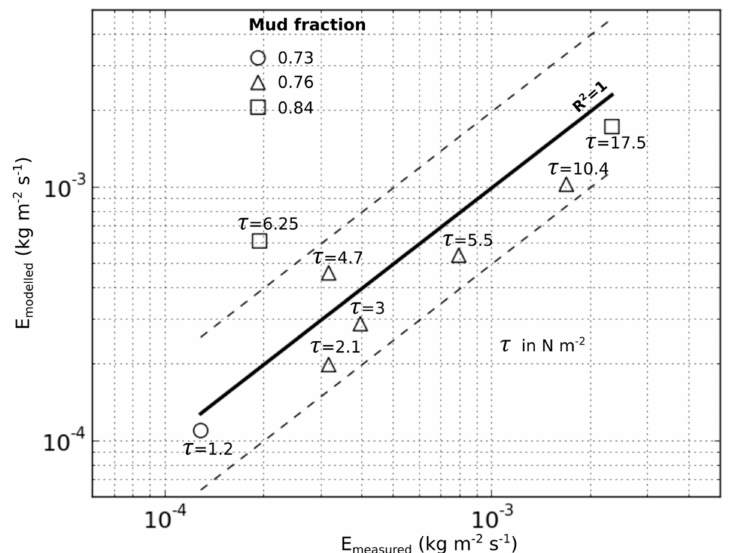
Figure 5. Comparisons of erosion fluxes deduced from erodimetry experiments conducted on muddy samples from the BoBCS and those computed from pure mud erosion law (Equation (1)) using similar shear stresses. Different symbols depict different sediment samples and labels refer to the applied shear stresses ( τ in N · m − 2 ). The solid black line represents perfect agreement between modelled and measured fluxes, and the dotted lines delimit the range linked to model overestimation or underestimation by a factor